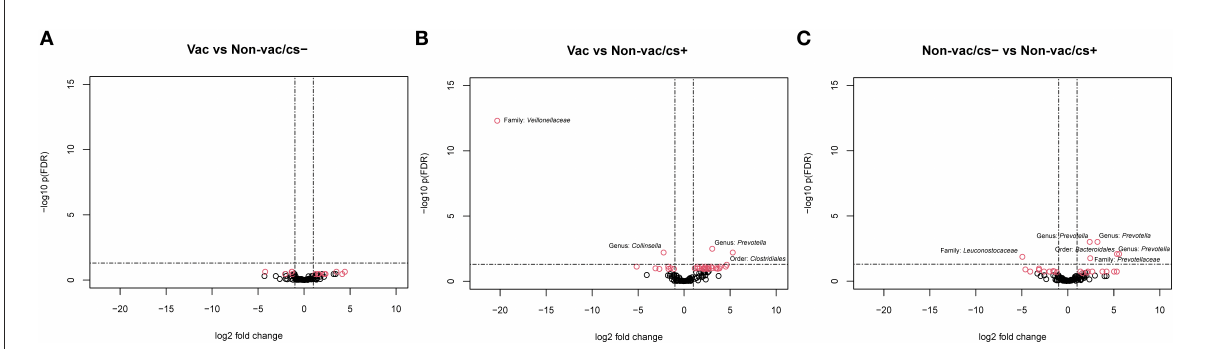
FIGURE3 Volcano plot visualizing –log10 FDR-adjusted p -values vs. log2-fold changes for all 124 OTUs between (A) Vac and Non-vac/cs–, (B) Vac and Non-vac/cs + , and (C) Non-vac/cs − and Non-vac/cs + . The horizontal lines show significance threshold for the adjusted p -values < 0.05. Each open point represents a single OTU. Open points above the significance threshold and beyond the log2-fold change criterion of ± 1 are indicated in red and bacterial taxonomy is